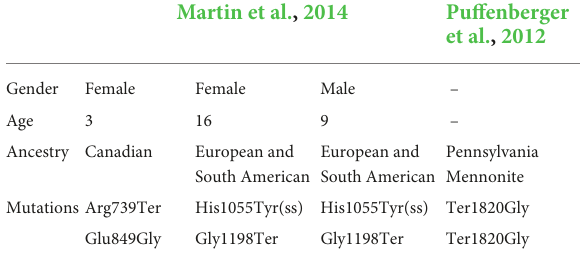
TABLE 2 Gender, age, and identified variants in previous literature for